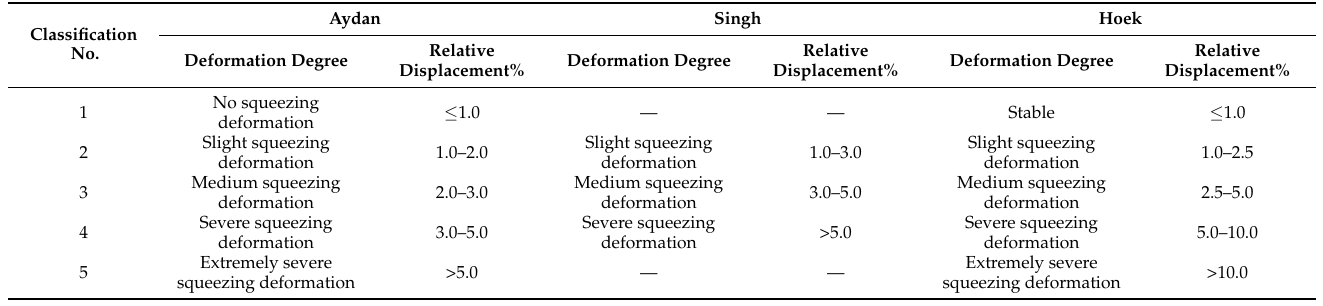
Table 1. Classification and comparison of squeezing deformation behaviors [48–51].